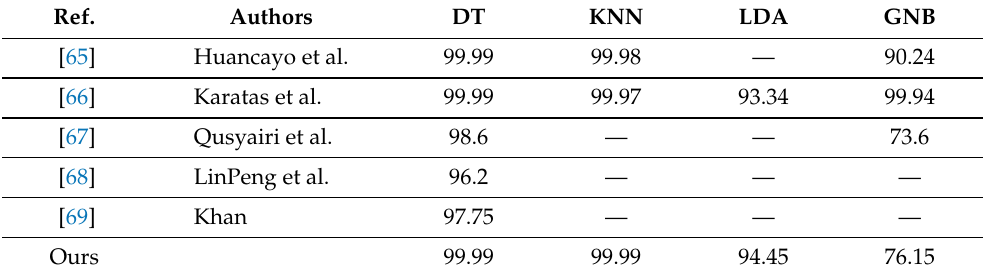
Table 9. Accuracy comparison based on Botnet attack on the same benchmark dataset.